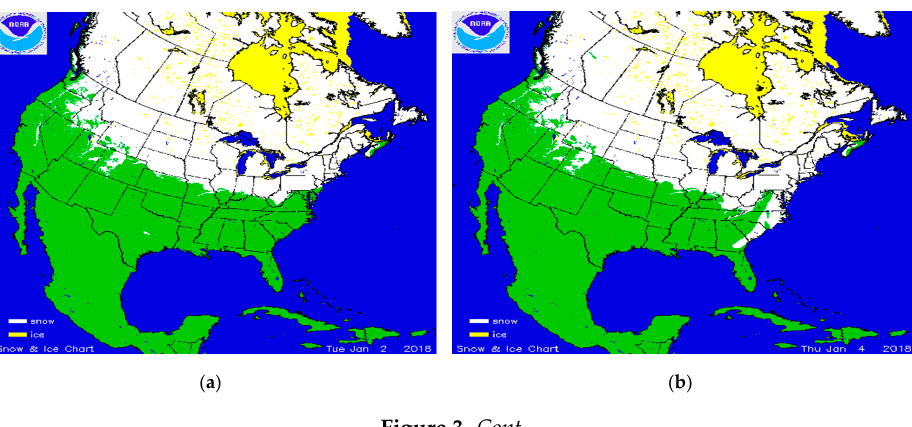
( c ) Figure 3. IMS snow maps on ( a ) 2 January and ( b ) 4 January 2018, respectively, and ( c ) NCEP Stage IV Multi-Sensor 24 h precipitation accumulation ending 5 January 2018 12 Zulu time.